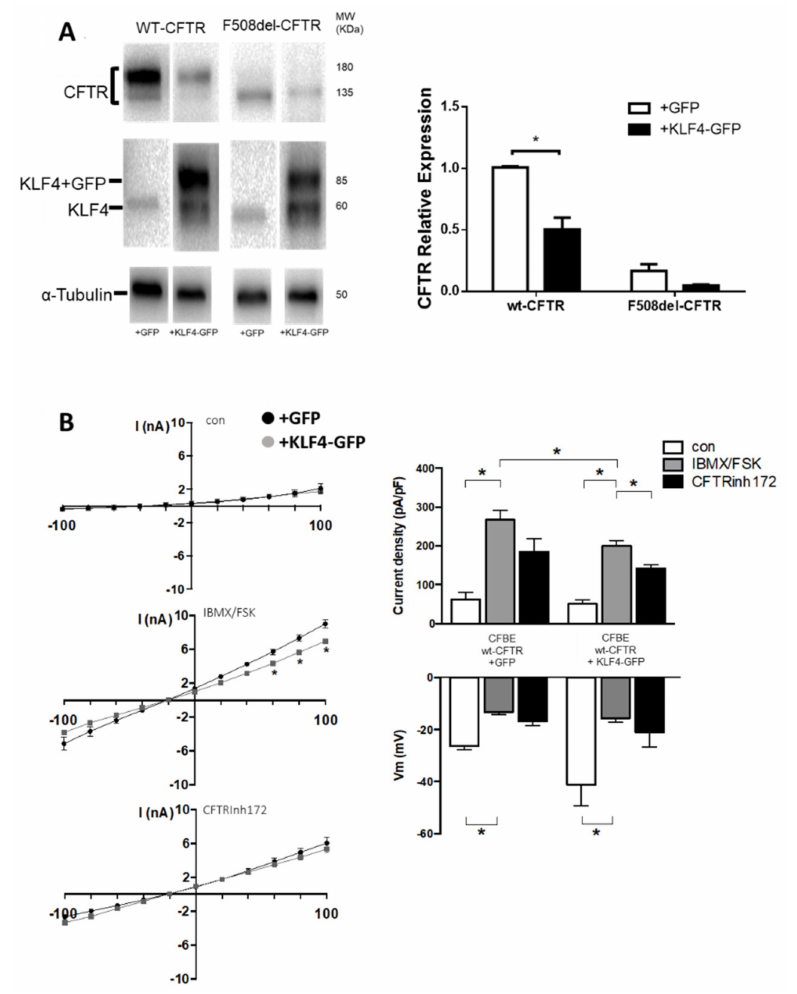
Figure 3. KLF4 overexpression caused a downregulation of wt-CFTR expression and function. ( A ) Transfection with KLF4-GFP was performed, and the e ff ects of KLF4 overexpression on